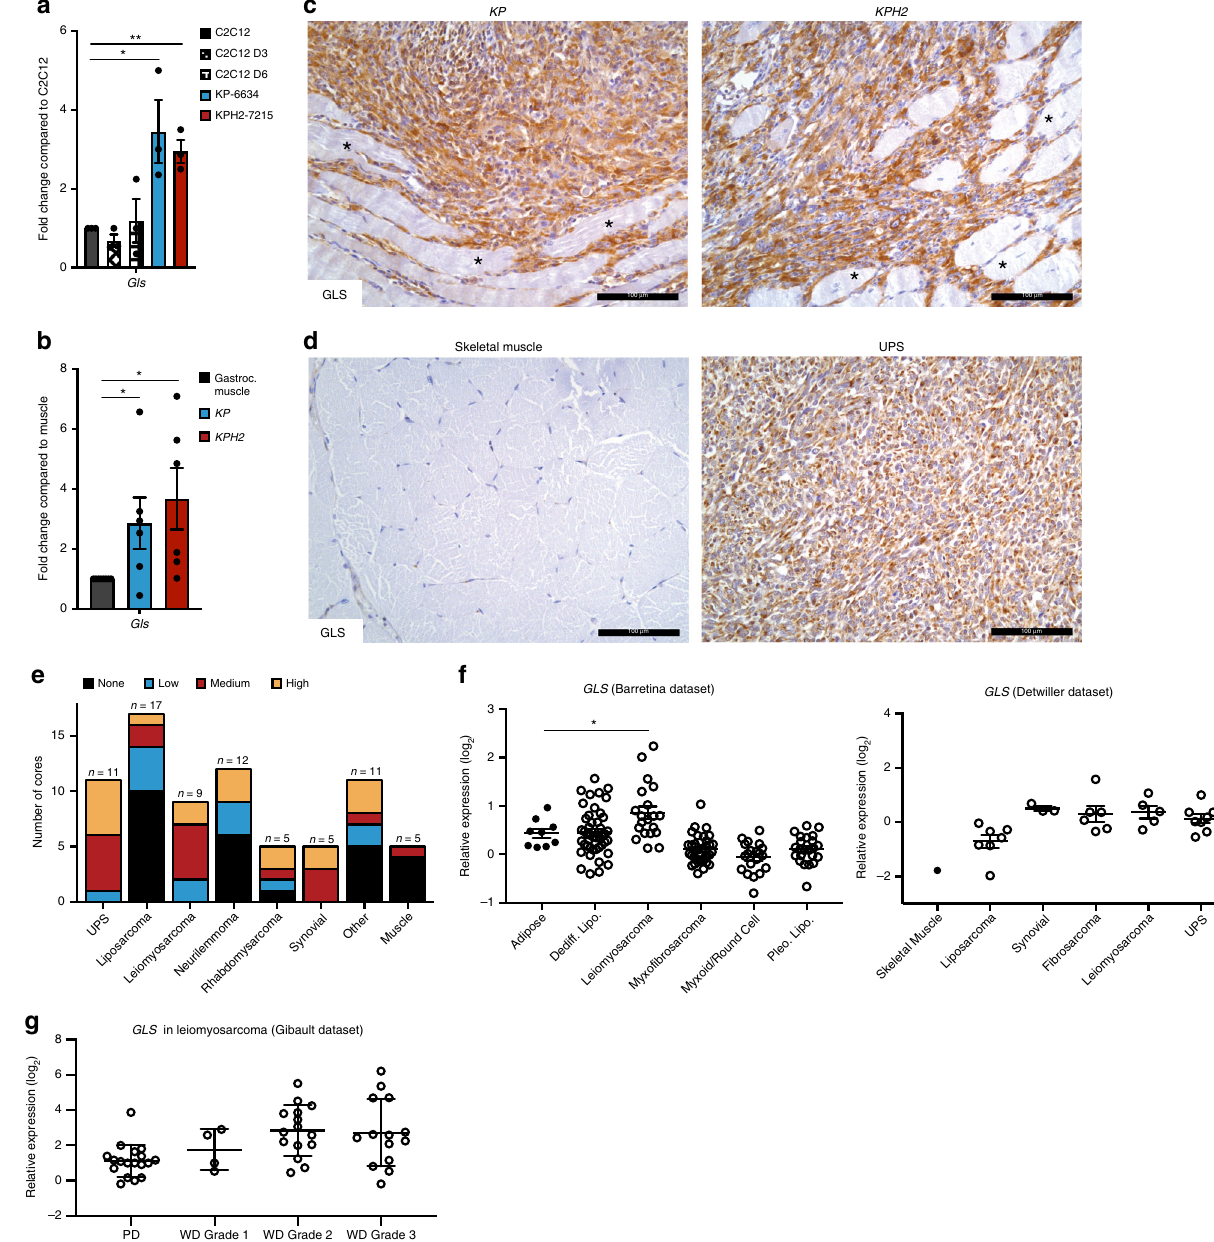
Fig. 4 Glutaminase 1 is highly expressed in UPS. a Gls mRNA levels in C2C12, C2C12 D3, C2C12 D6, KP-6634, and KPH2-7215 cells. N = 3 with three technical replicates. Data represent mean ± s.e.m.; * p < 0.05, ** p < 0.005. b Gls mRNA levels in gastrocnemius muscle, KP , and KPH2 tumours. N = 5 with three technical replicates. Data represent mean ± s.e.m. * p < 0.05. c Representative GLS staining in KP (left; n = 8) and KPH2 (right; n = 8) tumours. Asterisks indicate unstained skeletal muscle. Scale bars = 100 μ m. d GLS staining of human skeletal muscle (left; N = 5) and undifferentiated pleomorphic sarcoma (UPS; right; N = 11). Scale bars = 100 μ m. e Quanti fi cation of GLS staining intensity in an STS microarray. f GLS mRNA expression from Oncomine analysis of Barretina et al. 43 (left) and Detwiller et al. 44 (right) sarcoma patient samples datasets. Values are normalized to median-centred intensity and shown on a log 2 scale. Dediff. lipo., dedifferentiated liposarcoma; pleo. lipo., pleomorphic liposarcoma; UPS, undifferentiated pleomorphic sarcoma; * p < 0.05. g GLS mRNA expression from Oncomine analysis of Gibault et al. 45 leiomyosarcoma patient samples datasets. Values are normalized to median- centred intensity and shown on a log 2 scale. PD, poorly differentiated; WD, well differentiated. p -Values were calculated from a two-tailed Student ’ s t -test for a , b , f , g . Source data are provided as a Source Data fi (38.0%) or high (32.9%) for GLS using immunohistochemistry energetic and anabolic purposes that differentiate them from (Supplementary Fig. 4E, F). To determine whether GLS was fi brosarcoma, leiomyosarcoma, and rhabdomyosarcoma cells. elevated in other STS subtypes, a variety of STS tumours was These observations were further re fl ected by increased GLS examined. Similarly, UPS stained medium (45.5%) and high abundance in UPS tissues compared to skeletal muscle (Fig. 4d). (45.5%) for GLS, while leiomyosarcoma (medium, 55.6%; high, 22.2%) and synovial sarcoma (medium, 60%; high, 40%) were